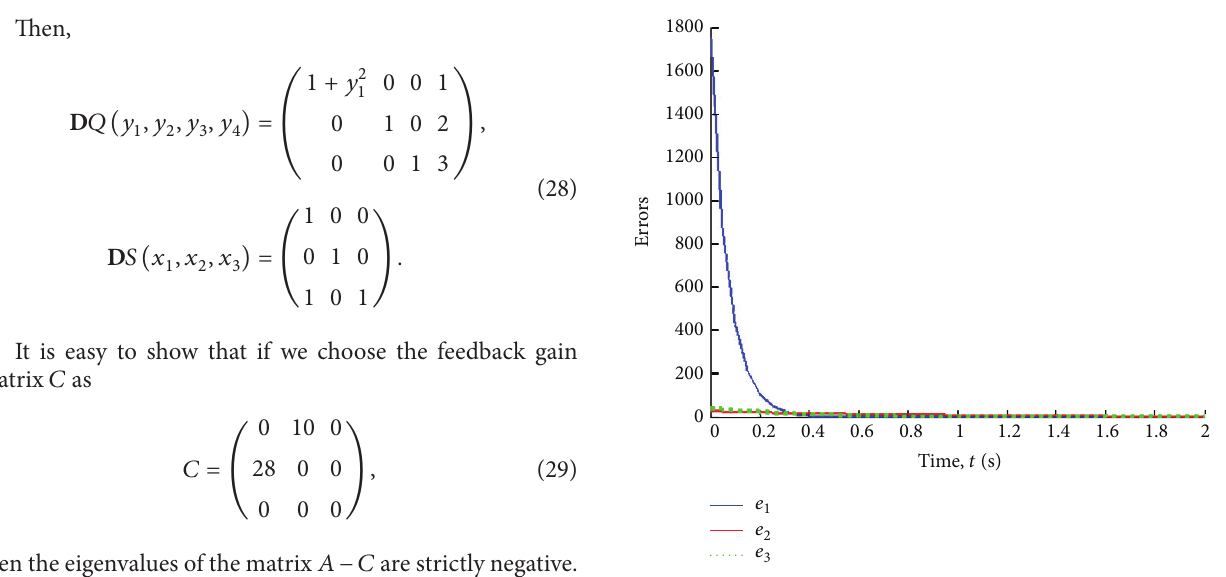
Figure 3: Time evolution of 𝑄 - 𝑆 synchronization errors between systems (24) and